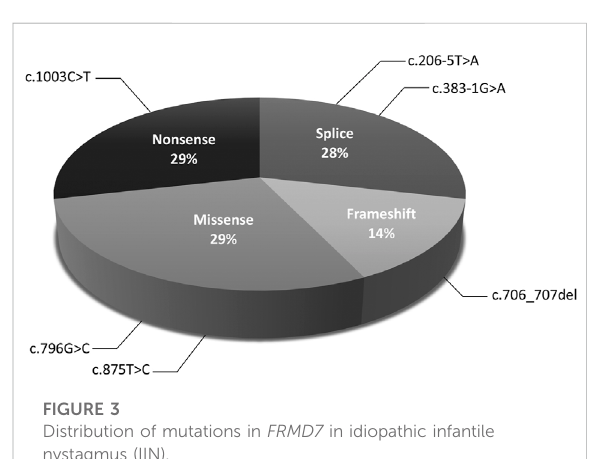
FIGURE 3 Distribution of mutations in FRMD7 in idiopathic infantile nystagmus